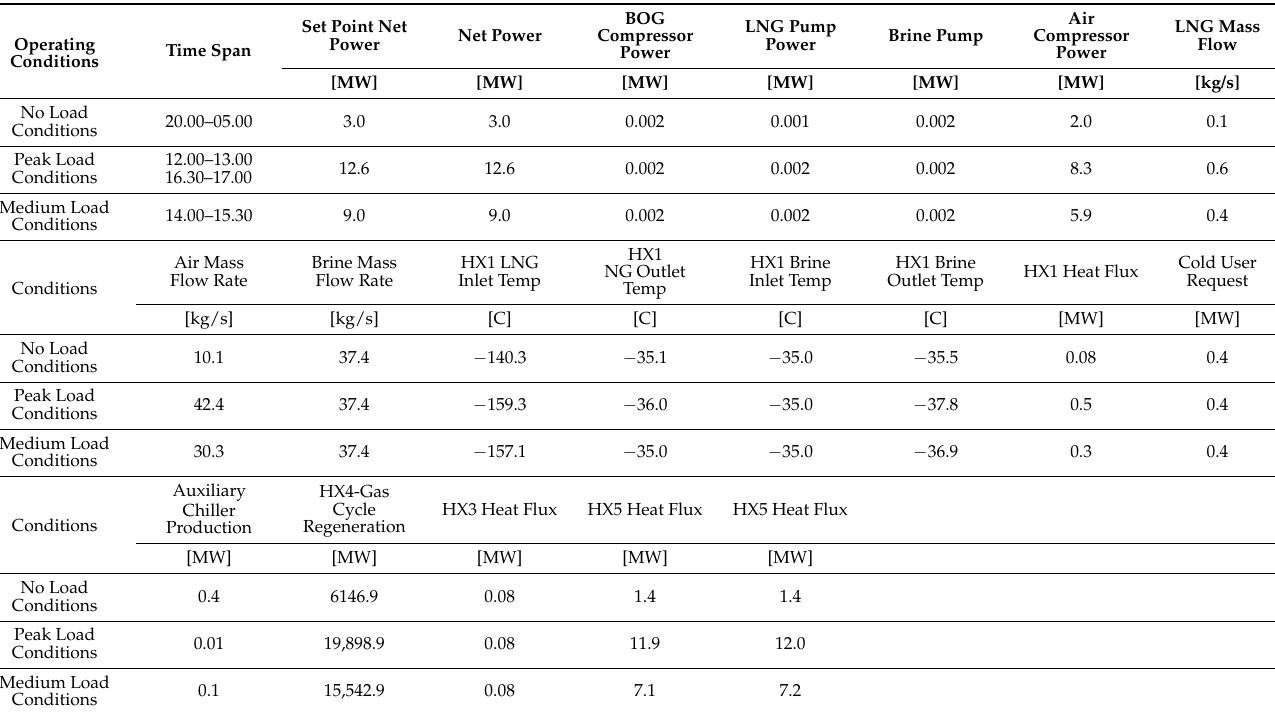
Table 2. Relevant Plant Operating Conditions for Peak, Medium, and No Load